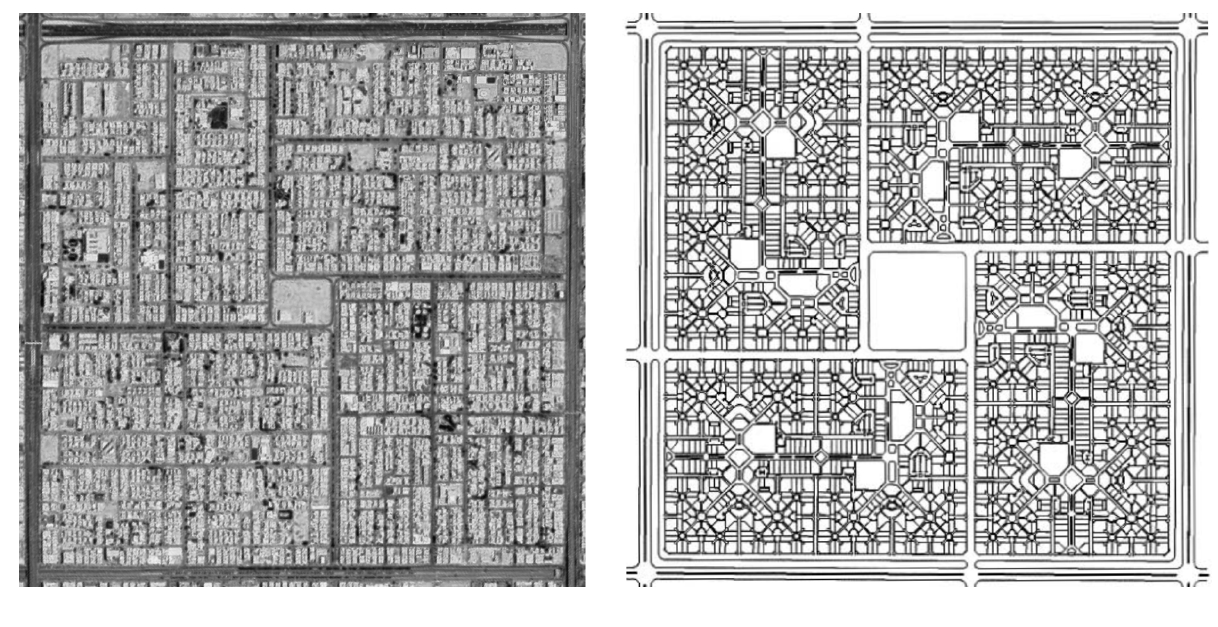
A Comparison between Doxiadis Superblock and one of MOMRA’s proposed new Superblocks. Left: Google Maps screenshot showing one of Doxiadis superblocks in Riyadh city. Source: Google Maps. Right: one of MOMRA’s proposed variation of the 2 x 2 superblocks.